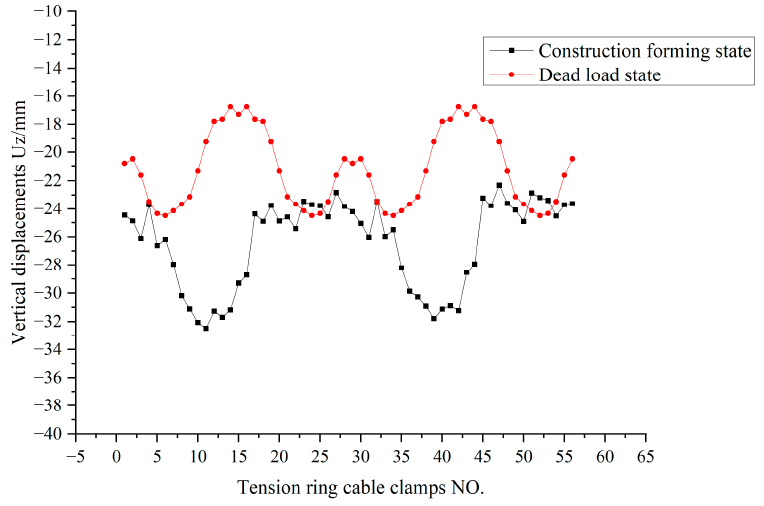
Figure 55. Comparison curve of vertical deformation of tension ring in two states (mm).